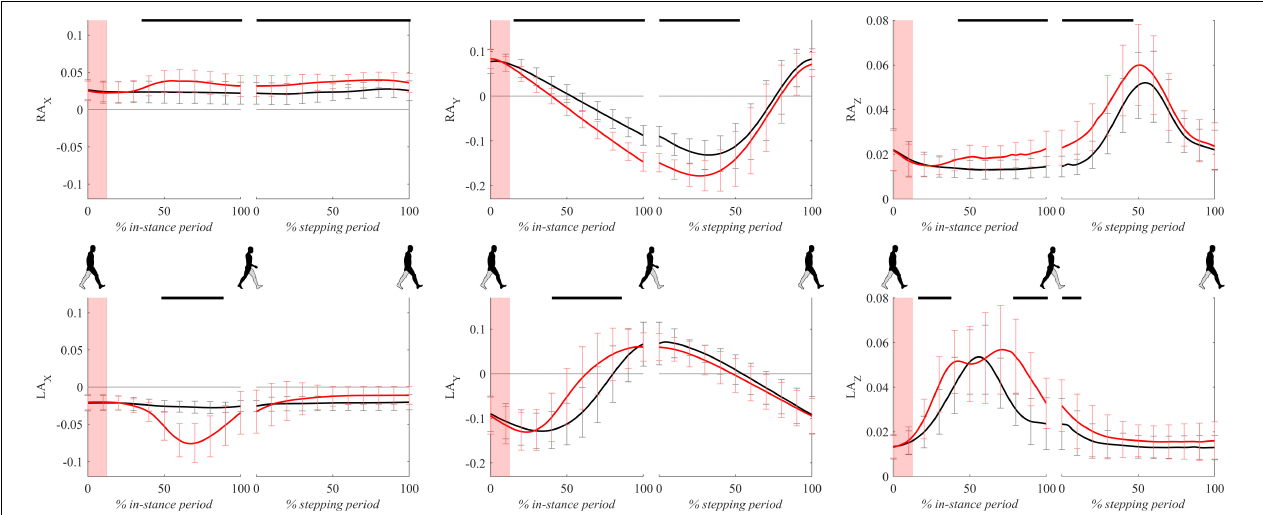
FIGURE 10 | Dimensionless group-average ankle trajectories (medial malleolus) of the right leg (RAx, RAy, and RAz) and the left leg (LAx, LAy, and LAz) after outward perturbations ( N = 11). Standard deviations are shown at each 10% of a gait cycle. Black corresponds with the unperturbed experimental condition, red with perturbed experimental conditions. One gait cycle divided into the in-stance and stepping periods, normalized to its duration separately for each experimental condition, is shown following a perturbing push. To visualize normalization of both periods short discontinuity is introduced on abscise. The perturbation period is marked with the red bar. Periods where statistically significant changes were determined between both experimental conditions are indicated with piece-wise continuous black lines on top of each